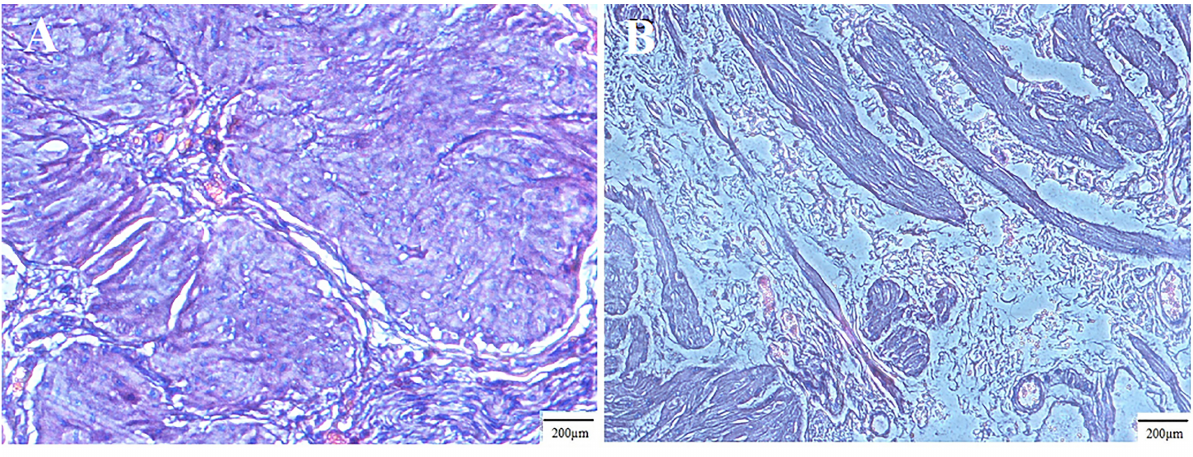
Figure 2 - H&E staining: Decellularized preputial (A) and skin tissues (B).